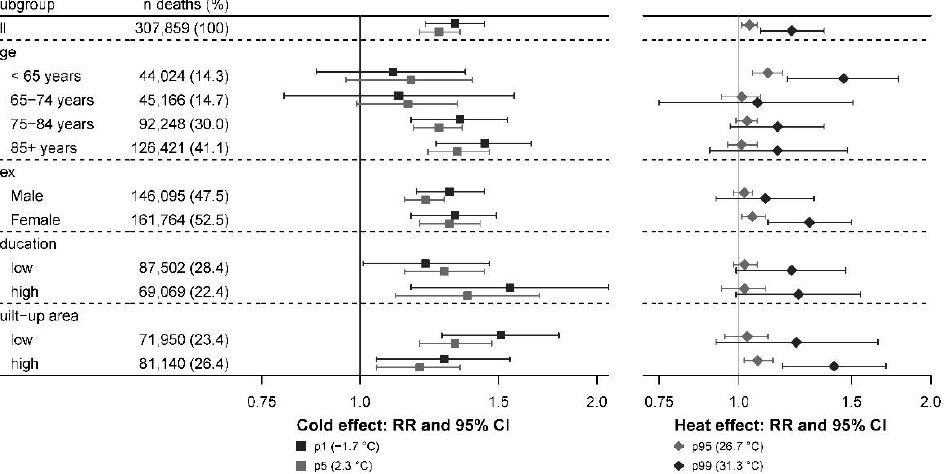
Figure 3. Pooled overall cumulative temperature–mortality associations by cause of death, 2010–2015.